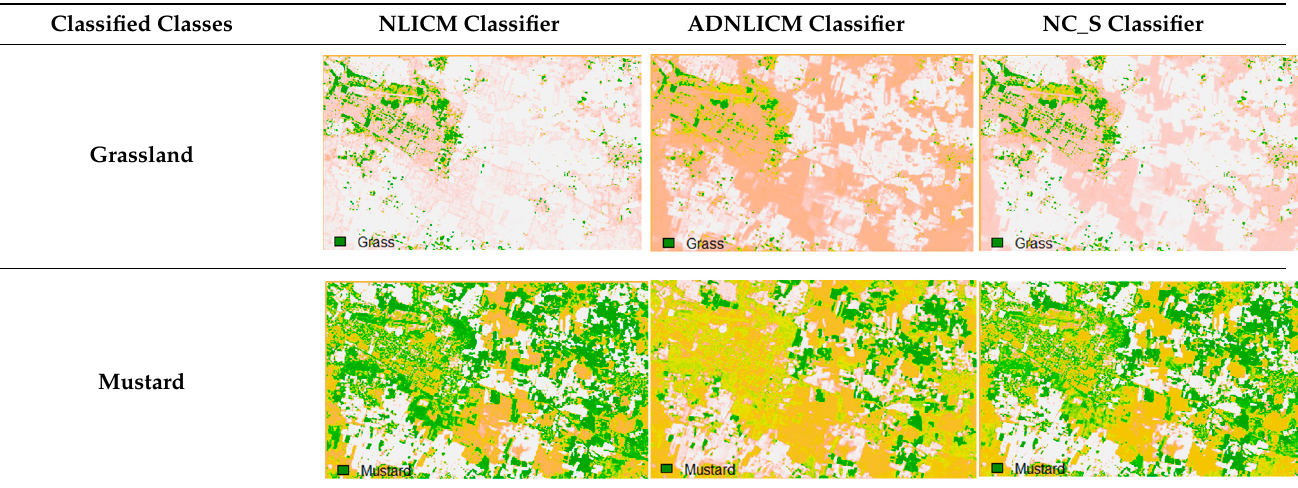
Table 14. Classified classes for site 1